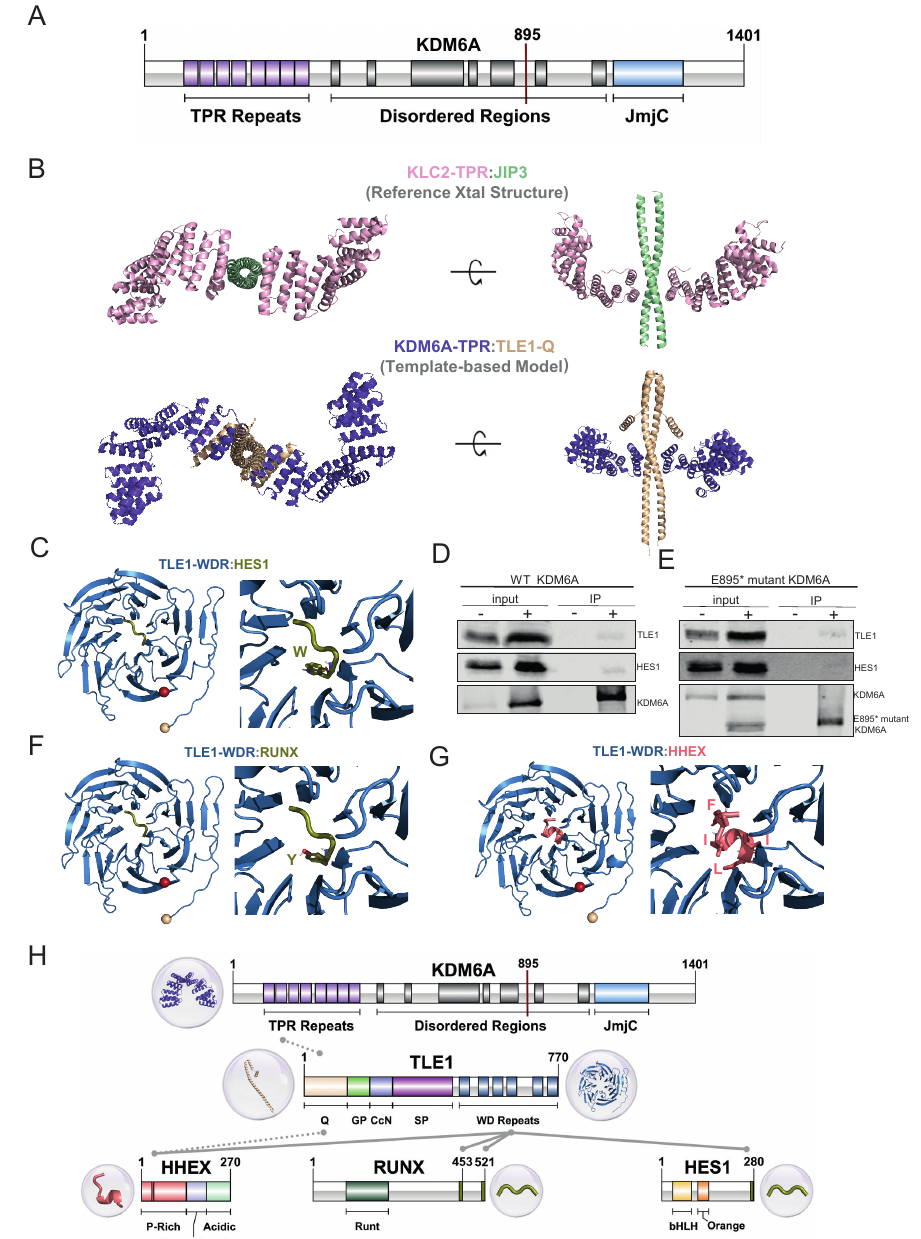
Figure 5. KDM6A TPR motif related interactions. ( A ) Domain illustration of KDM6A . ( B ) Modeling of KDM6A -TPR: TLE1 -Q. The reference structure, containing KLC2 -TPR (pink) and JIP3 (light green), is given in the first row (PDB ID: 6EJN). Our KDM6A -TPR (purple) and TLE1 -Q (wheat) interaction model is shown in the second row. ( C , F , G ) Refined structures for TLE1 -WDR containing interactions, together with the interacting motif closeups. N-ter (wheat) and C-ter (red) are represented by spheres. ( D , E ) Immunoprecipitation using anti-FLAG affinity gel in HEK293T cells expressing wild-type FLAG-tagged KDM6A ( D ) and E895* mutant FLAG-tagged KDM6A ( E ). Western blot images show the bands detected for WT- KDM6A , truncated KDM6A , TLE1 , and HES1 . ‘ − ’ and ‘+’ denote the untransfected and transfected HEK293T cells, respectively, for the input and IP samples. ( H ) Overall representation of interactions of co-repressors with KDM6A and TLE1 at domain level. Gray lines represent interacting regions between proteins, the source of the interaction is grouped as literature information and structural evidence, shown with dotted and solid lines, respectively. Three-dimensional structures are also provided for each interacting